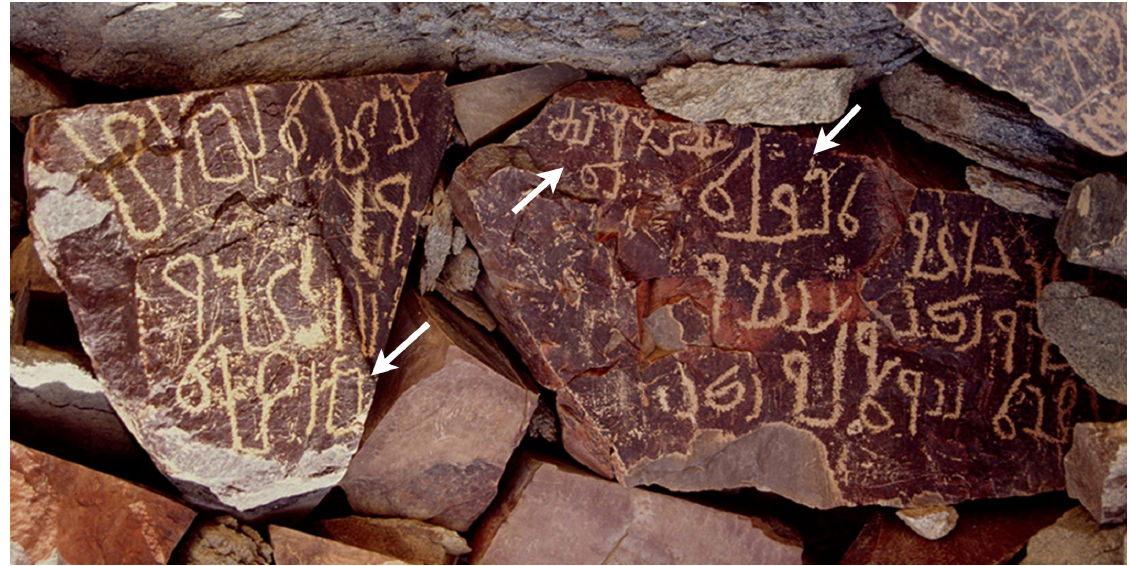
Figure 20 Nabataean inscriptions in the Bedouin cult enclosure of Jebel Moneijah, the titles are marked by arrows, from right to left: “ אלפכא ” (high priest), “ אבתכ ” (scribe) and “ ארקבמ ” (sacrifice inspector) ( CIS II 2, Nos.